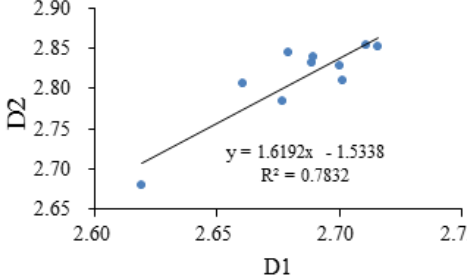
Figure 7. Relationship between D1 and D2.